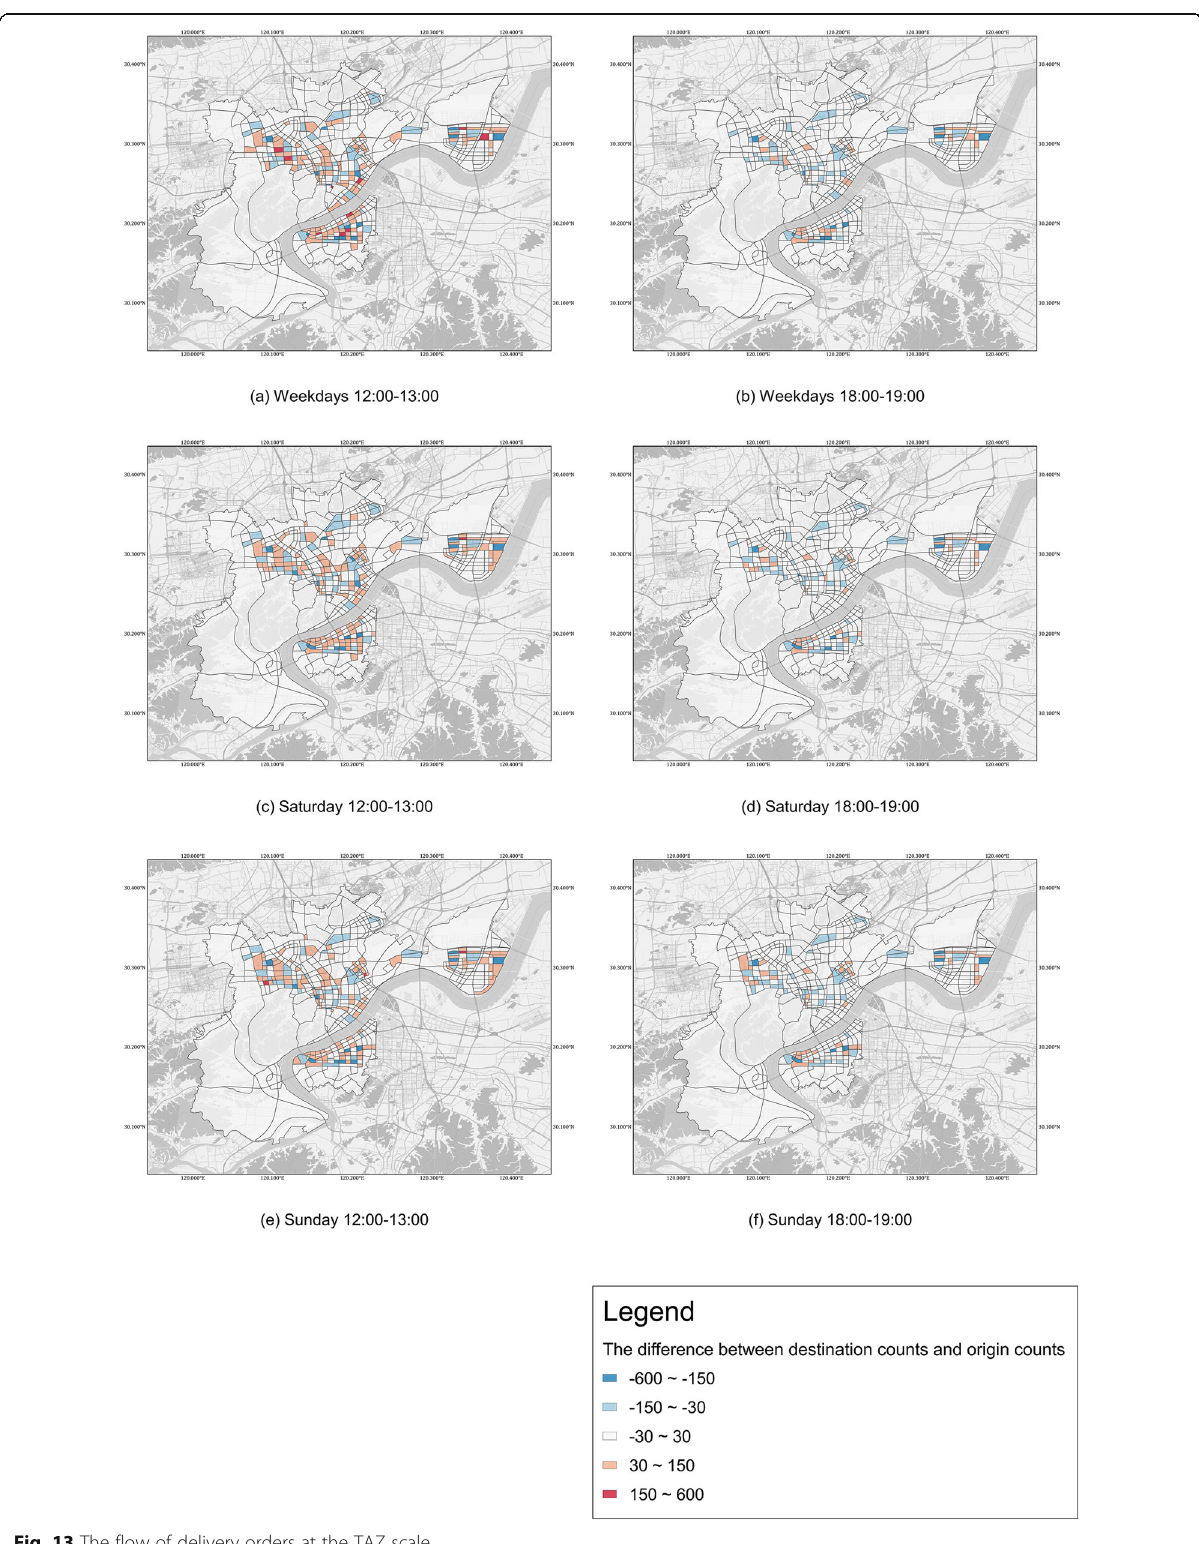
Fig. 13 The flow of delivery orders at the TAZ